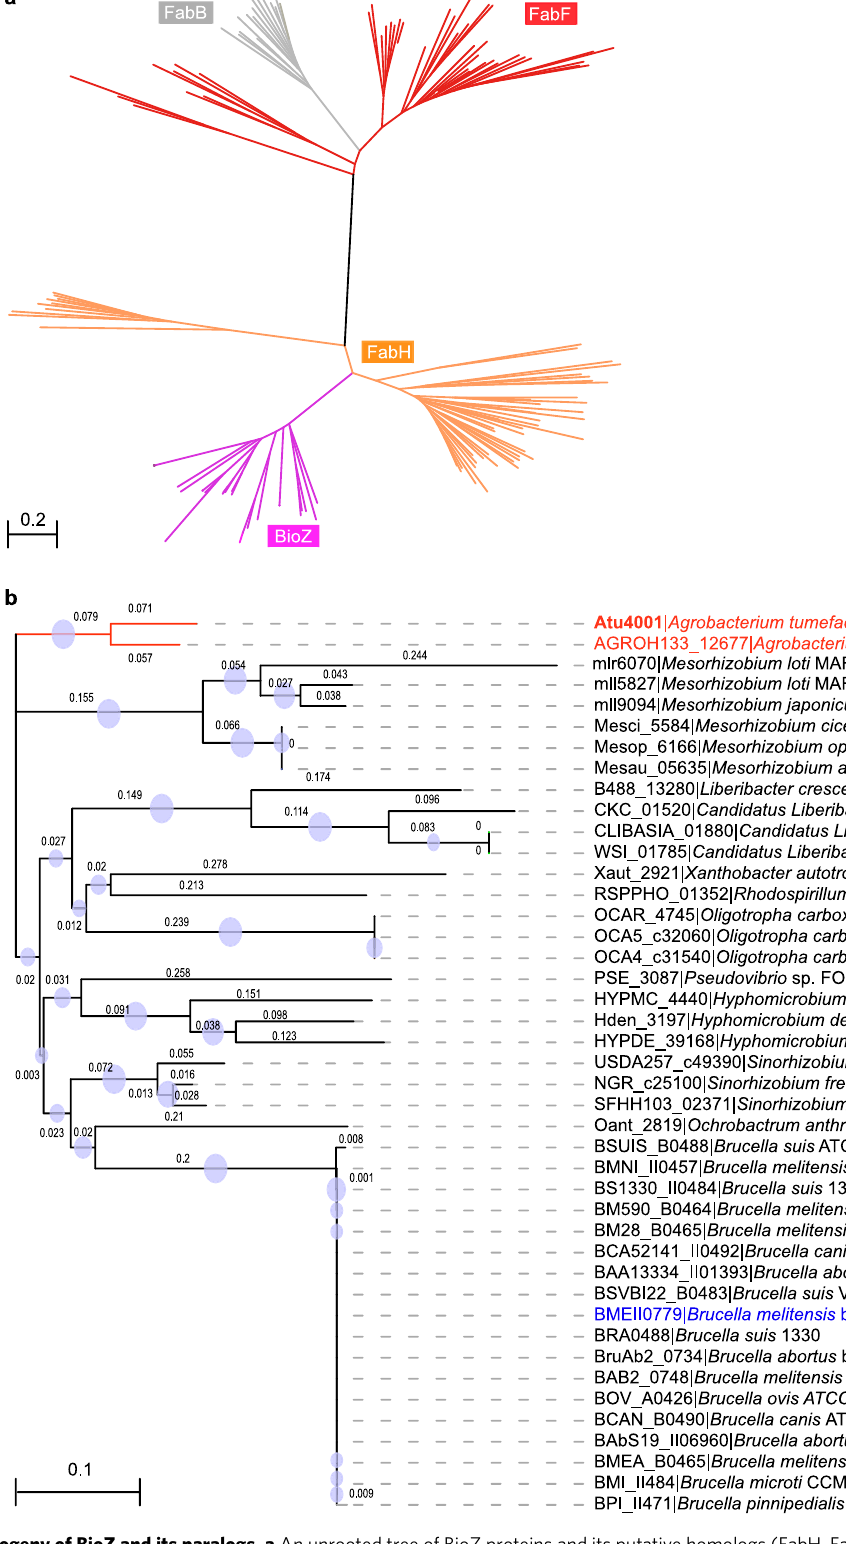
NATURE COMMUNICATIONS| (2021) 12:2056